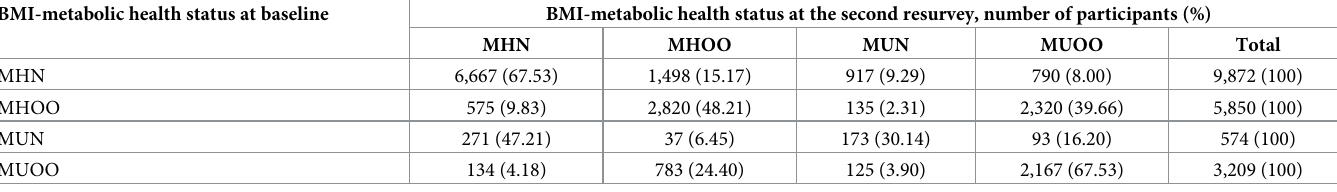
Table 3. Transition of BMI-metabolic health status from baseline to the second resurvey. BMI-metabolic health status at baseline BMI-metabolic health status at the second resurvey, number of participants (%) MHN MHOO MUN MUOO Total MHN 6,667 (67.53) MHOO 575 (9.83) MUN MUOO BMI, body mass index; MHN, metabolically healthy normal weight; MHOO, metabolically healthy overweight or obesity; MUN, metabolically unhealthy normal weight; MUOO, metabolically unhealthy overweight or